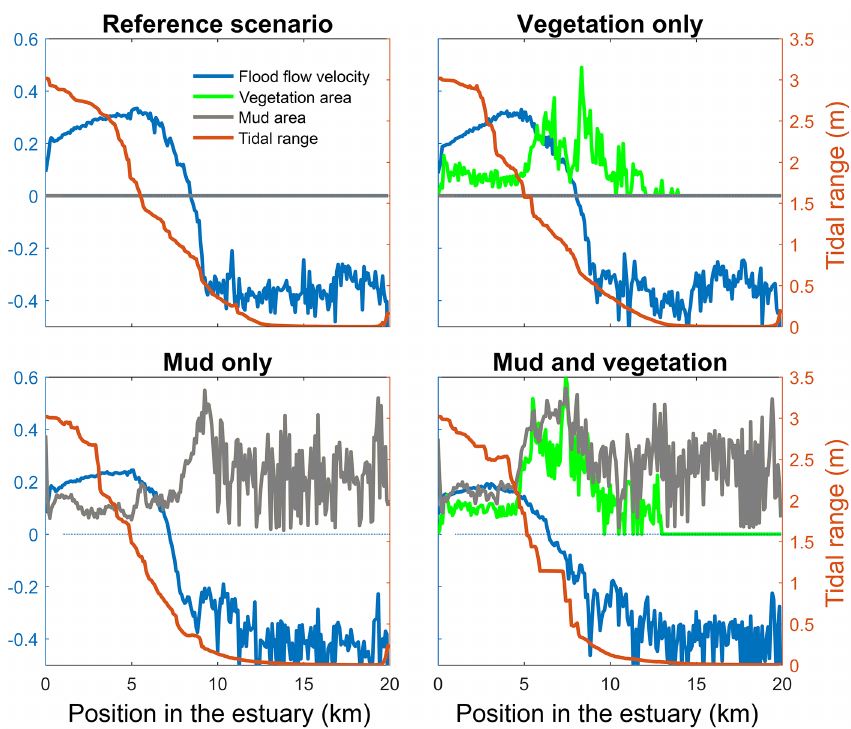
Figure 4. Tidal range, maximum flood flow velocity, vegetation cover and mud cover as a fraction of the estuary width plotted against landward distance from the coastline. In all four figures the left axis is used for three variables: width averaged flood velocity, mud cover and vegetation cover. The right axis is used for the maximum tidal range of the estuary cross section in all four subplots.